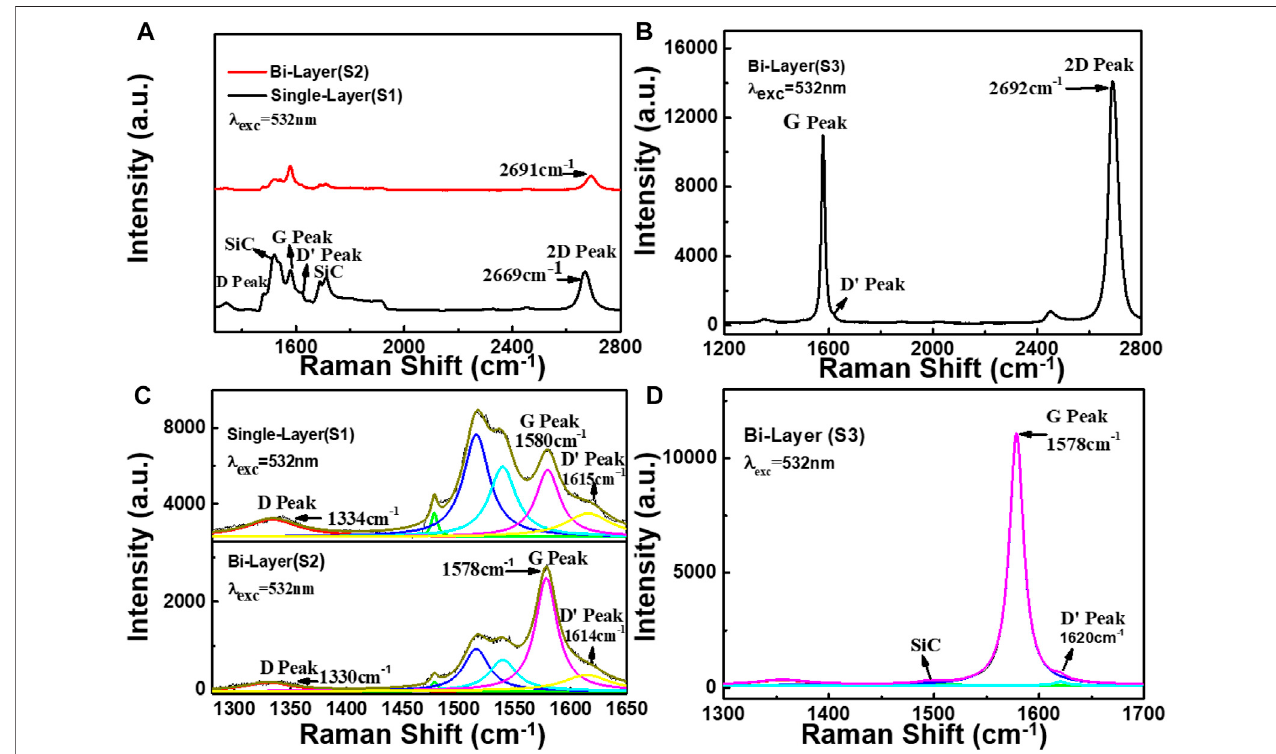
FIGURE 3 | Room-temperature Raman spectra of graphene samples (S1), (S2), and (S3), respectively. (A,B) are the Raman spectra of the samples (S1), (S2), and (S3), respectively. (C,D) are the Lorentz fi tting of the samples (S1), (S2), and (S3), respectively.